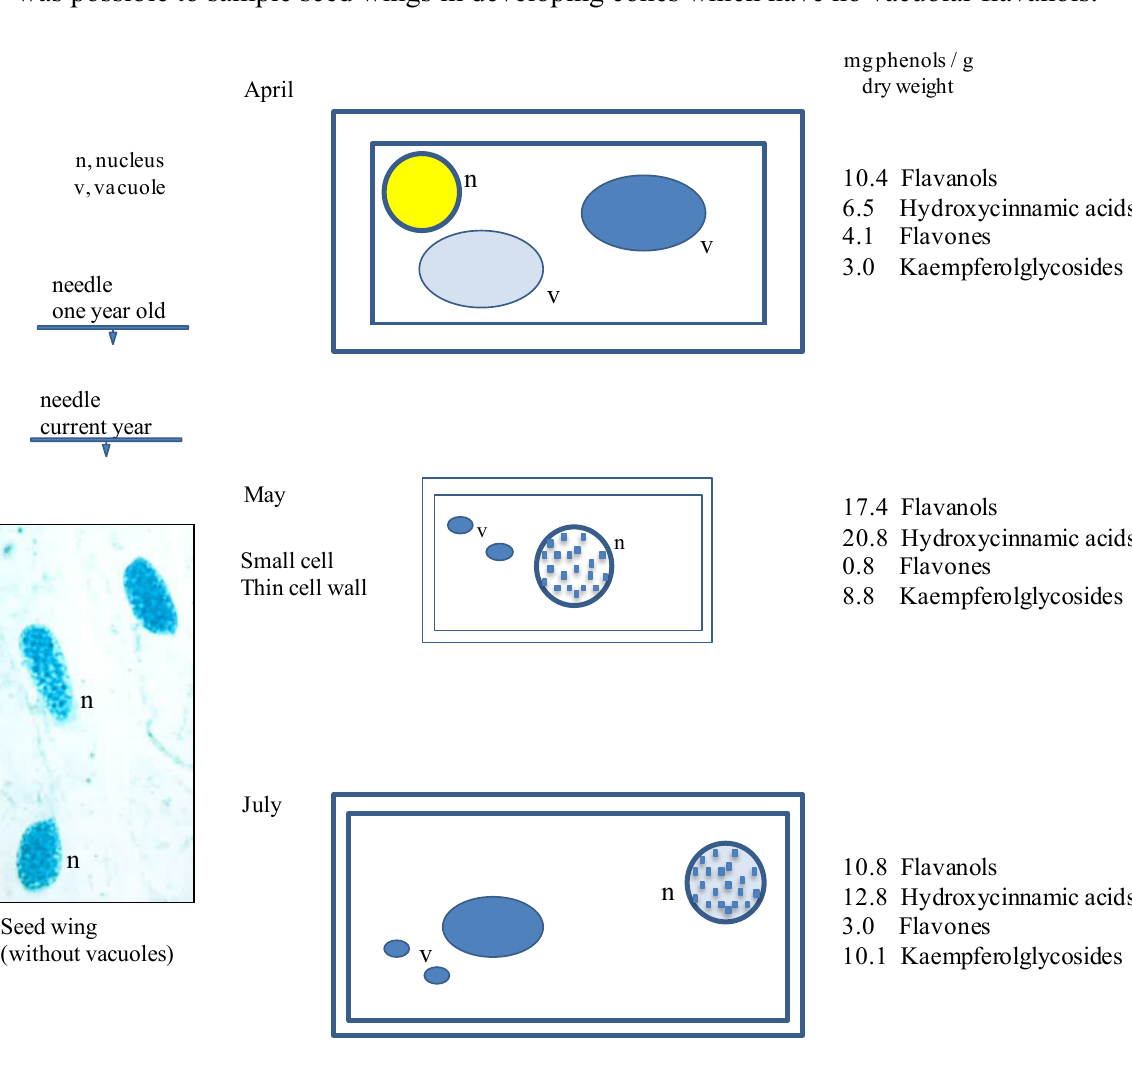
Figure 3. Total content of phenols at different stages of Tsuga canadensis needle development; the different cell sizes and thickness of cell walls together with different amounts of vacuolar flavanols made it impossible to quantify nuclear flavanols; however, it was possible to sample seed wings in developing cones which have no vacuolar